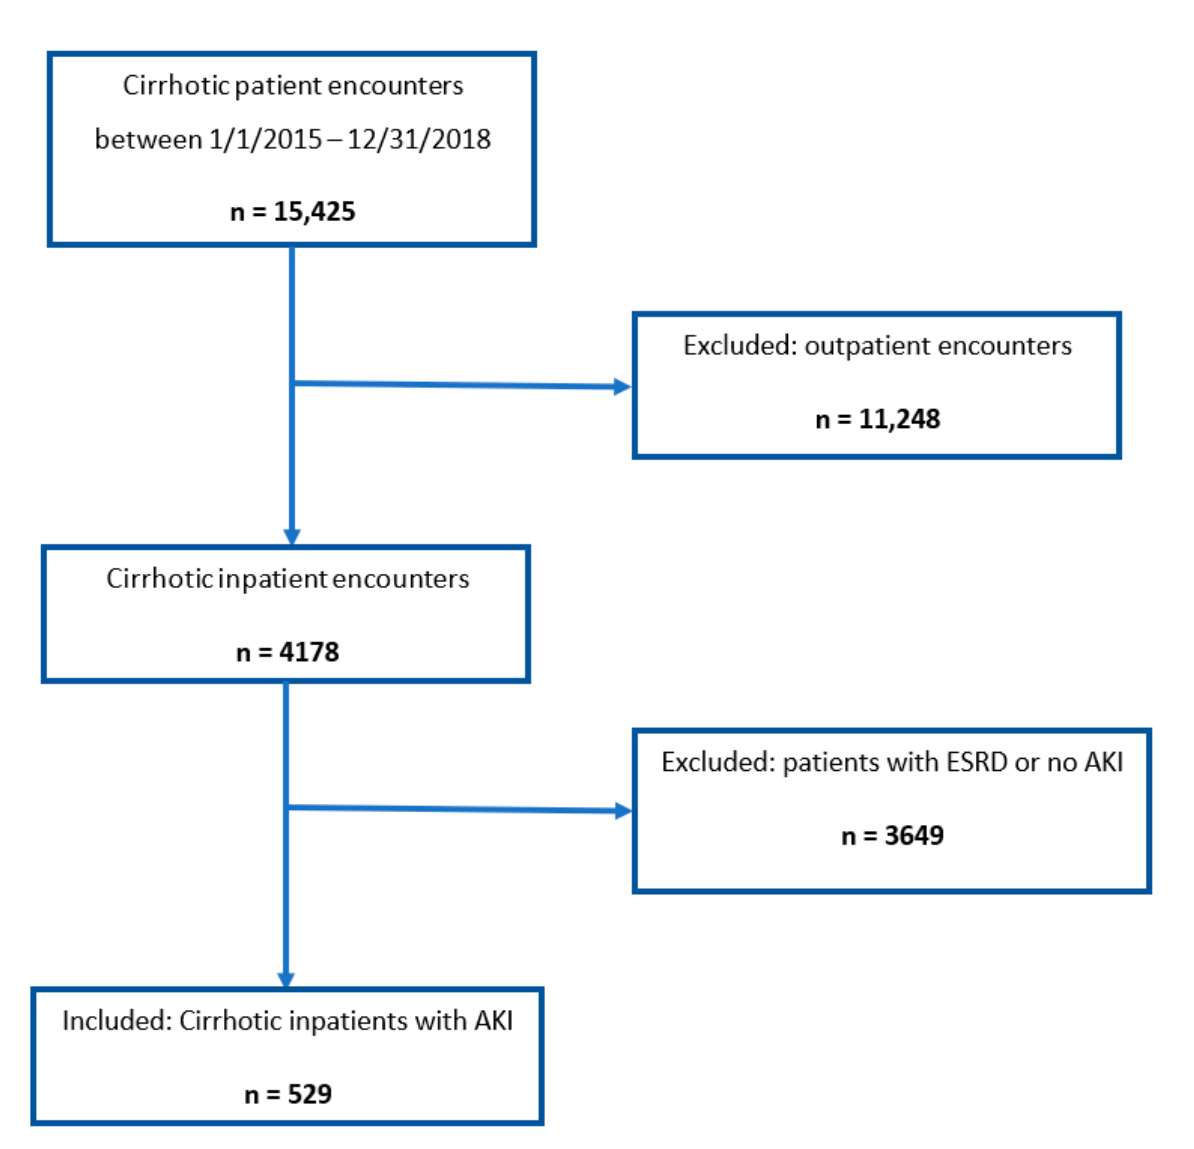
Figure 1. Consort diagram demonstrating inclusion and exclusion criteria. Table 1. Clinical characteristics and outcomes of cirrhotic patients admitted with Acute Kidney Injury